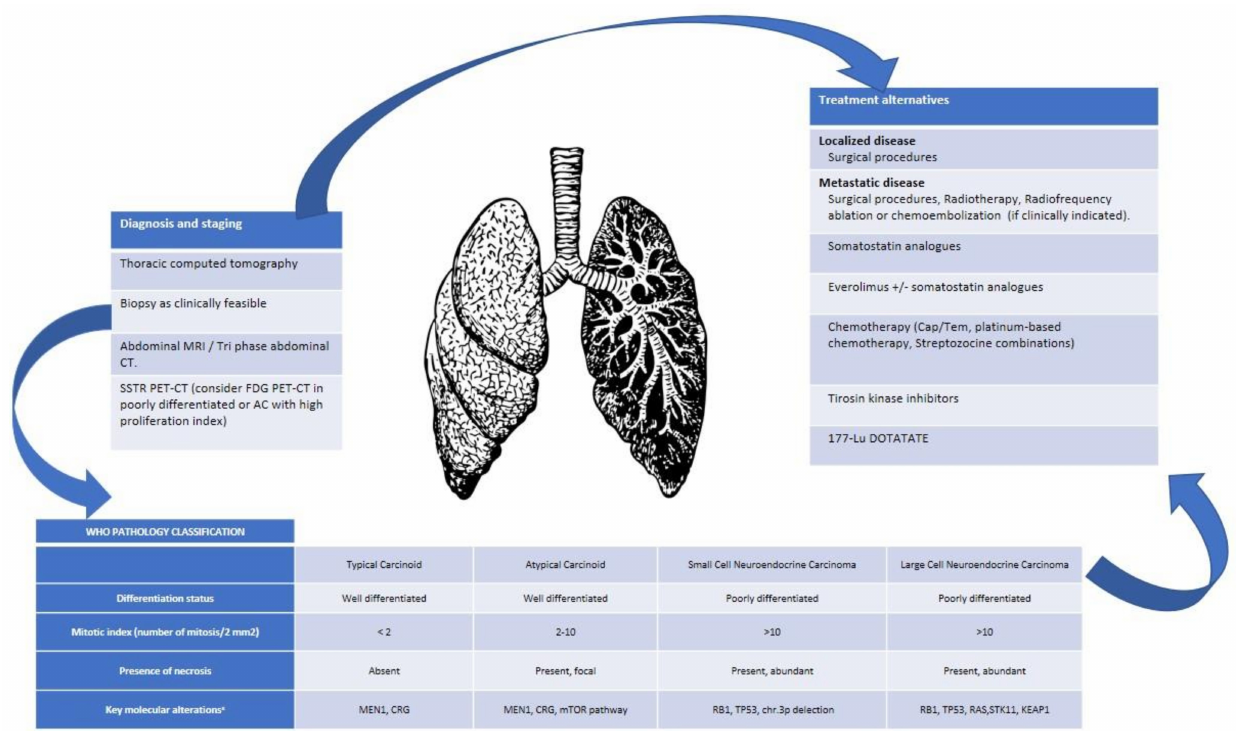
Figure 3. Integrative algorithm of current management in lung NENs. * No specific data for NET-G3 available. Cap/Tem, capecitabine/Temozolomide; chr., chromosome; CT, computed tomography; FDG, fluorodeoxyglucose; G, grade; IV, intravenous; LOH, loss of heterozygosity; MRI, magnetic resonance imaging; NEC, neuroendocrine carcinoma; NET, neuroendocrine tumour; PET-CT, positron emission tomography-computed tomography; sd., syndrome; SSTR, somatostatin